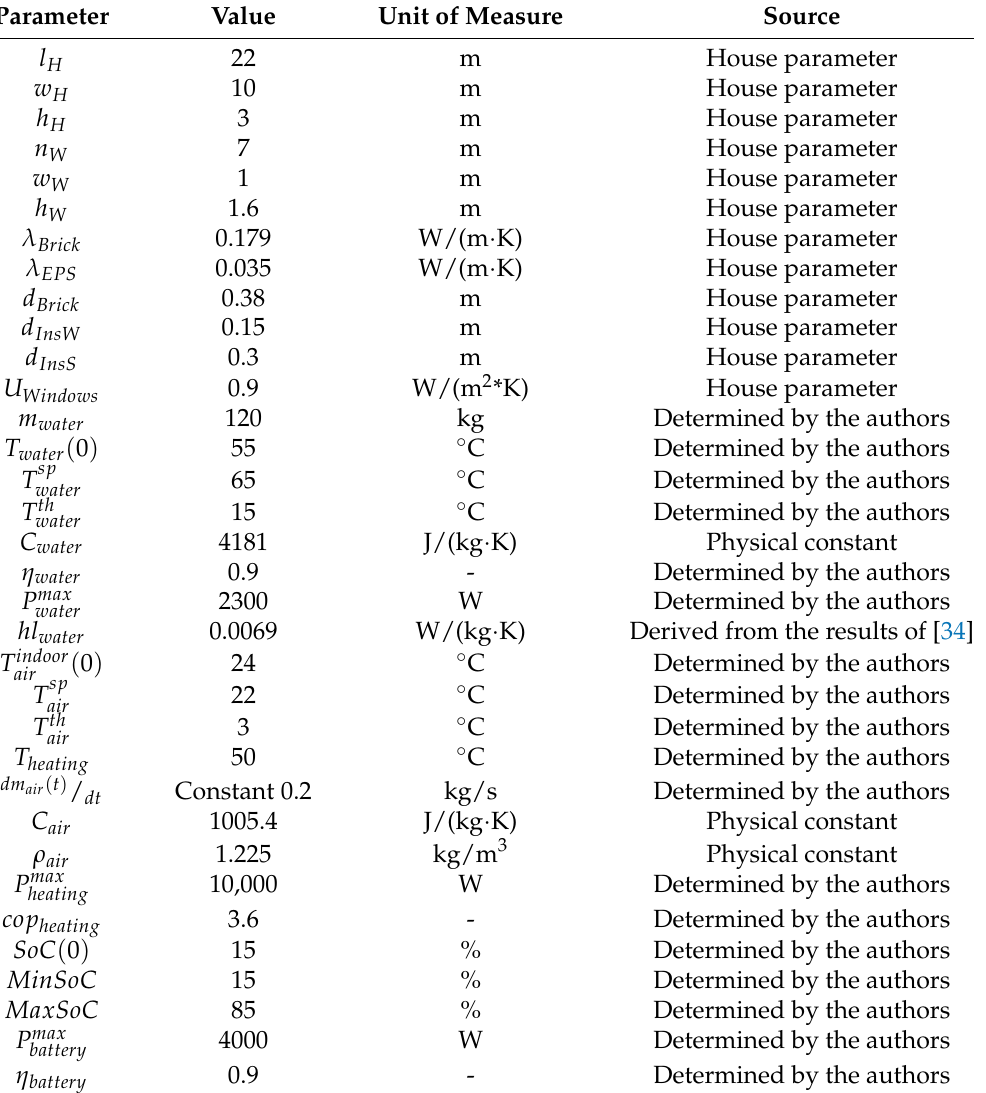
Table A1. Simulation